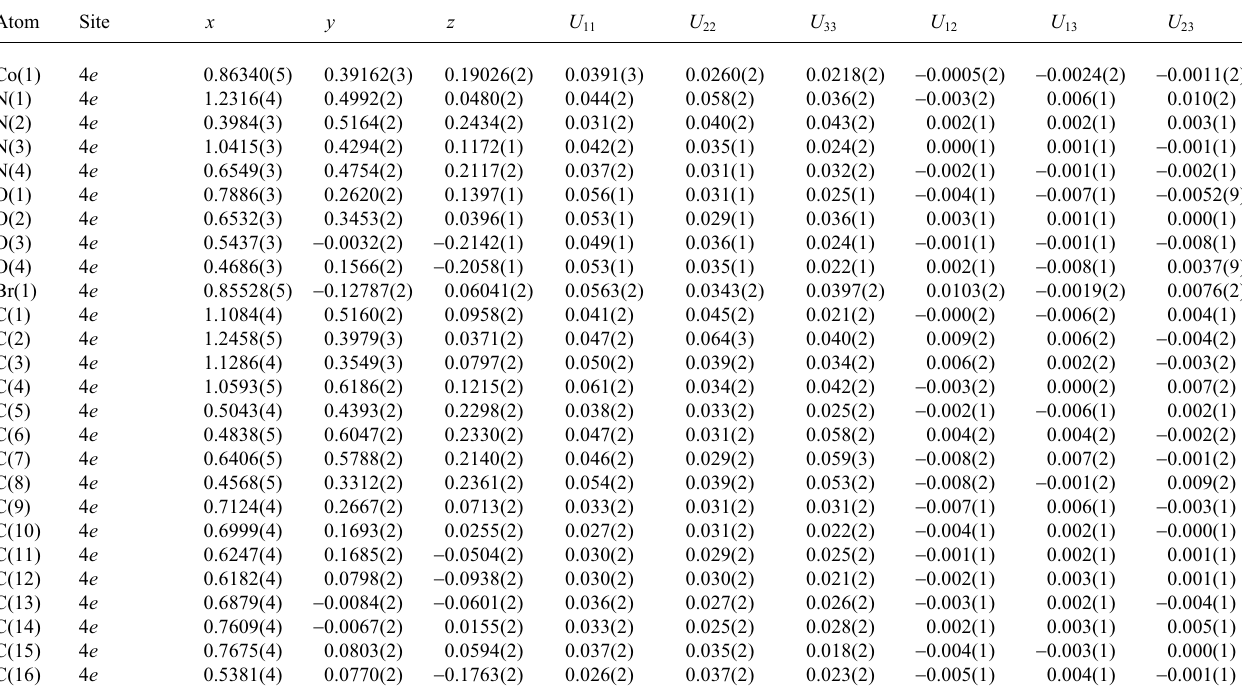
Table 3. Atomic coordinates and displacement parameters (in Å 2 )